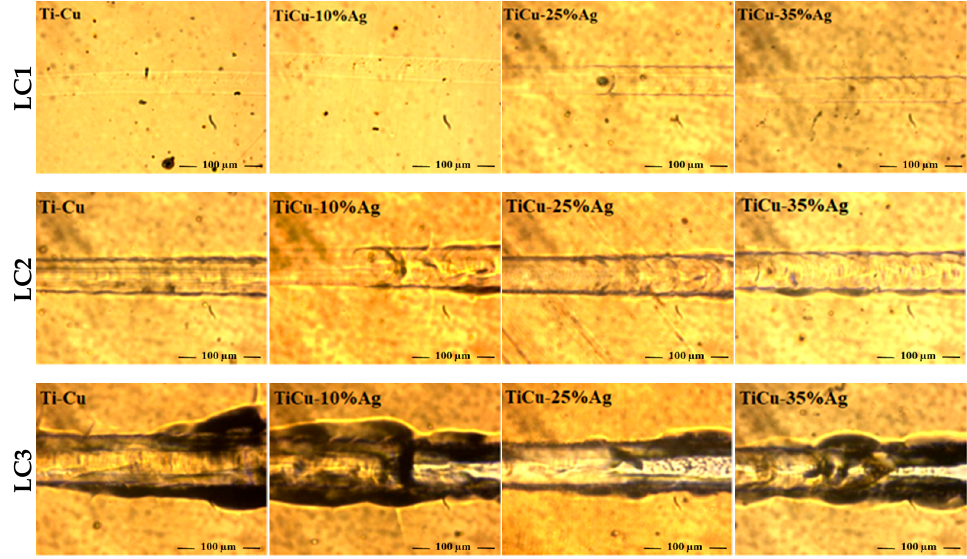
Figure 7. Representation of first failure LC1, second failure LC2, and complete delamination LC3 for the TiCu and TiCuAg thin films (scratch direction from left to right).